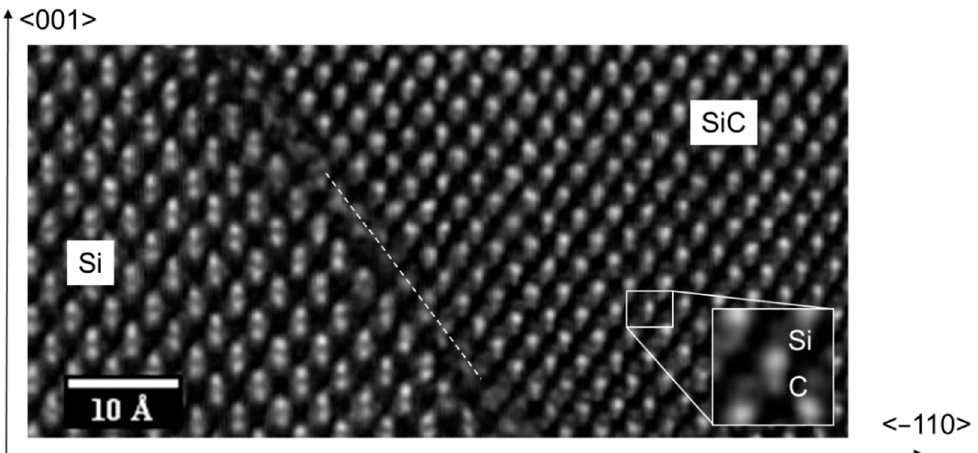
Figure 4. High-resolution STEM image of the heterointerface along the pyramid face. Si/SiC interface is projected on (110) plane. The white dotted line represents the interface between Si and SiC crystals. In the lower right part, a magnification of the silicon and carbon diatom is shown.